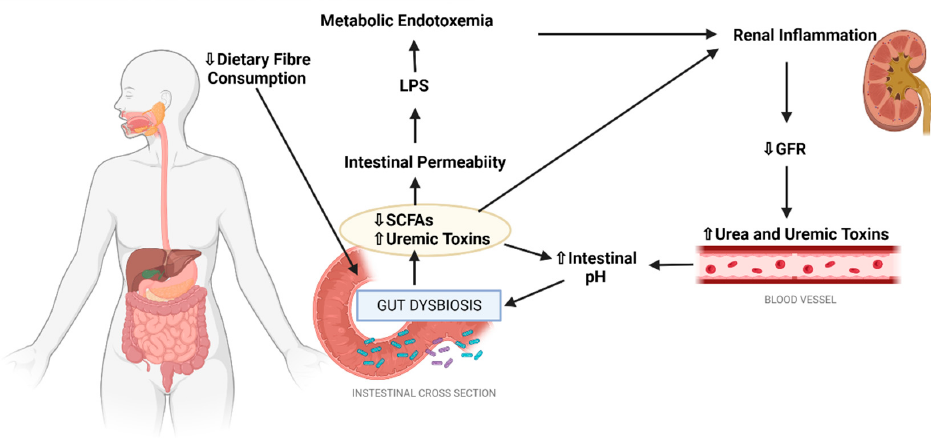
Figure 3. Overview of the gut-kidney axis in DKD. GFR: Glomerular Filtration Rate, LPS: Lipopolysaccharide, SCFA: Short Chain Fatty Acid, ↑ : Increased, ↓ : Decreased. Created with Biorender.com.